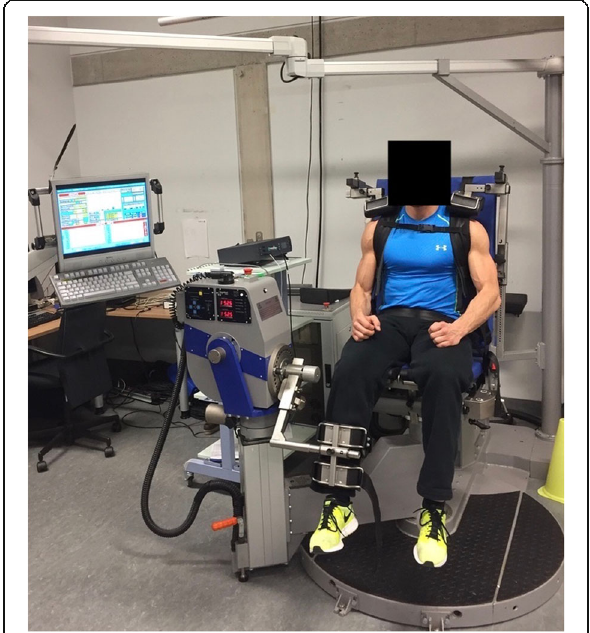
Fig. 2 Setup for measurements of the maximum voluntary isometric contraction (MVIC) with a rotational